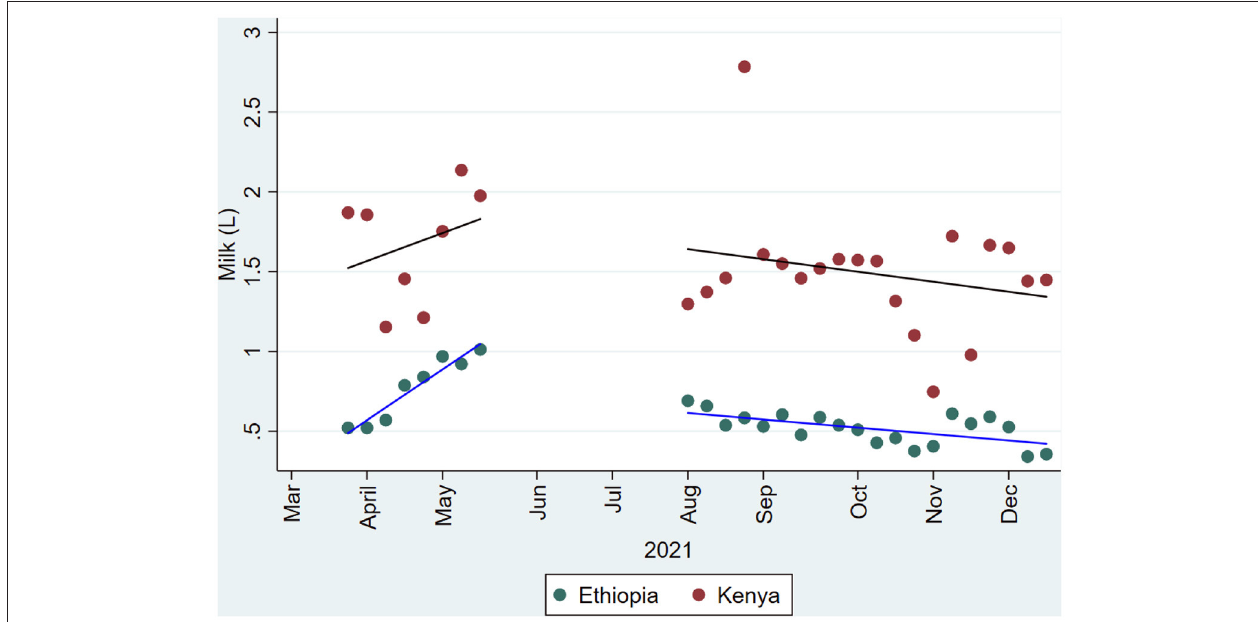
FIGURE 8 | Twenty-four-hour milk production of sampled pastoral households in Kenya and Ethiopia.